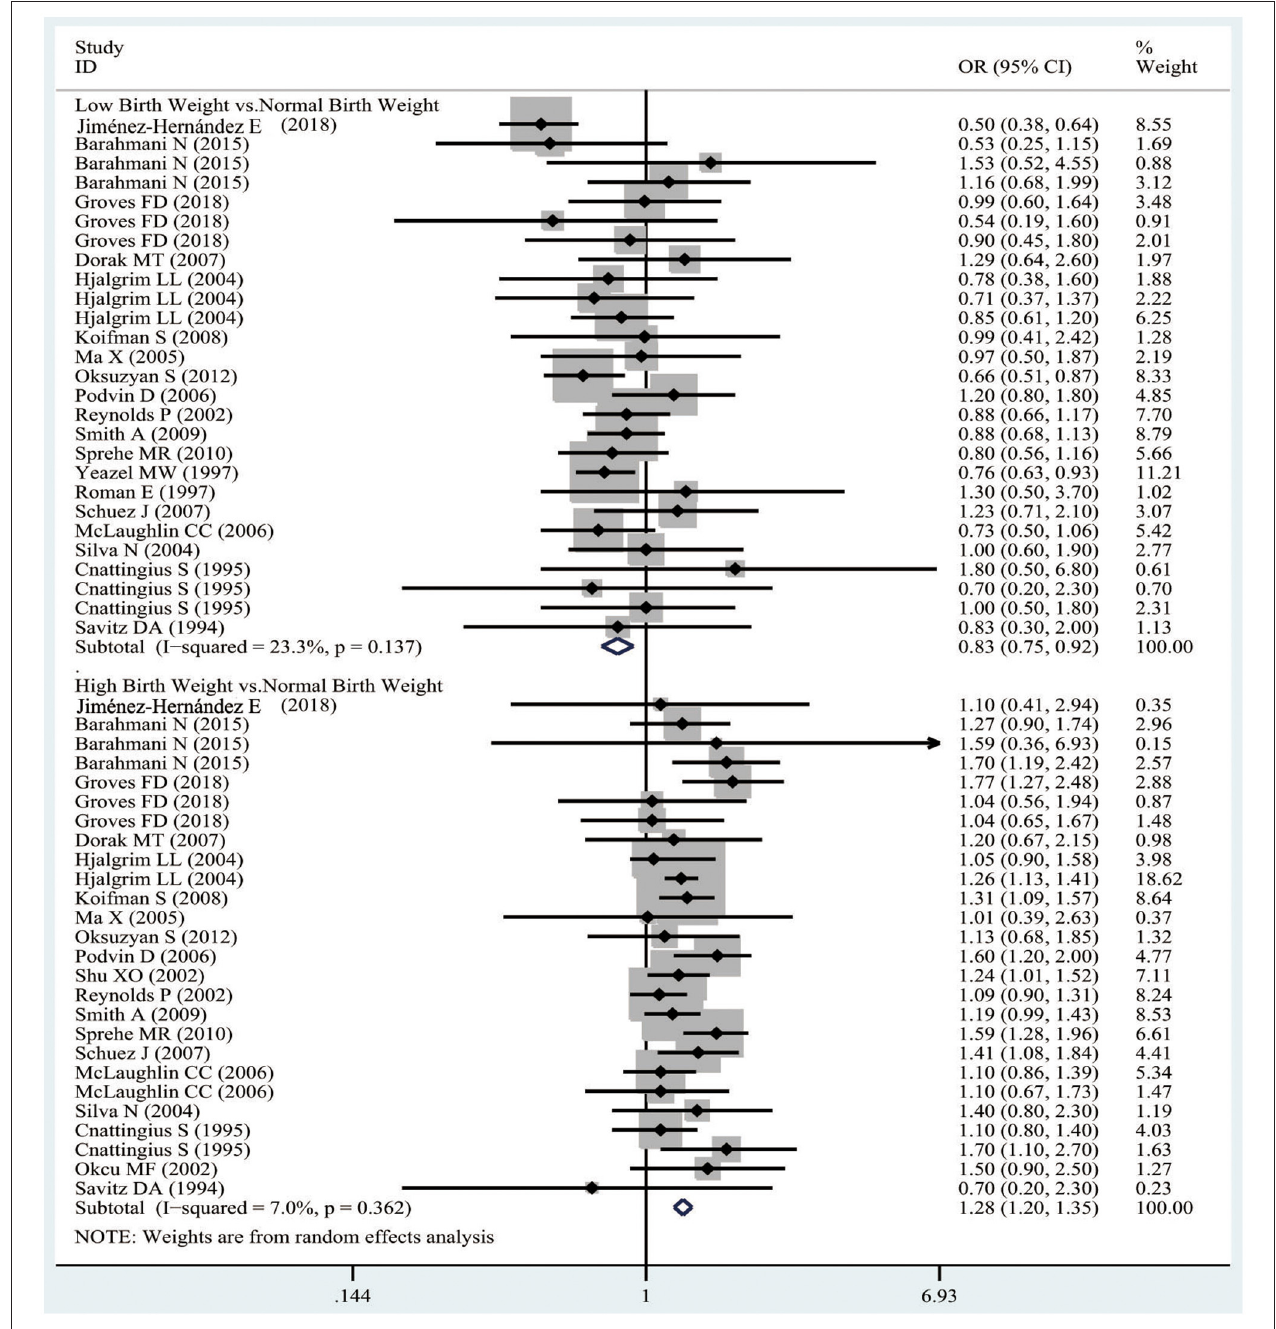
FIGURE 3 | The odds ratios for low birth weight, high birth weight, and